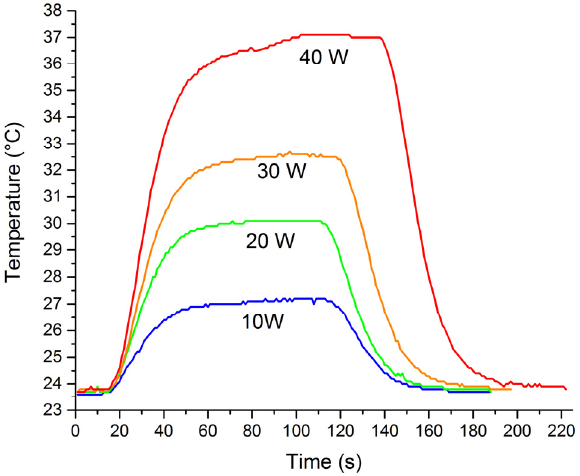
Figure 6. The outlet temperature of water at a constant flow rate for different set heating powers.